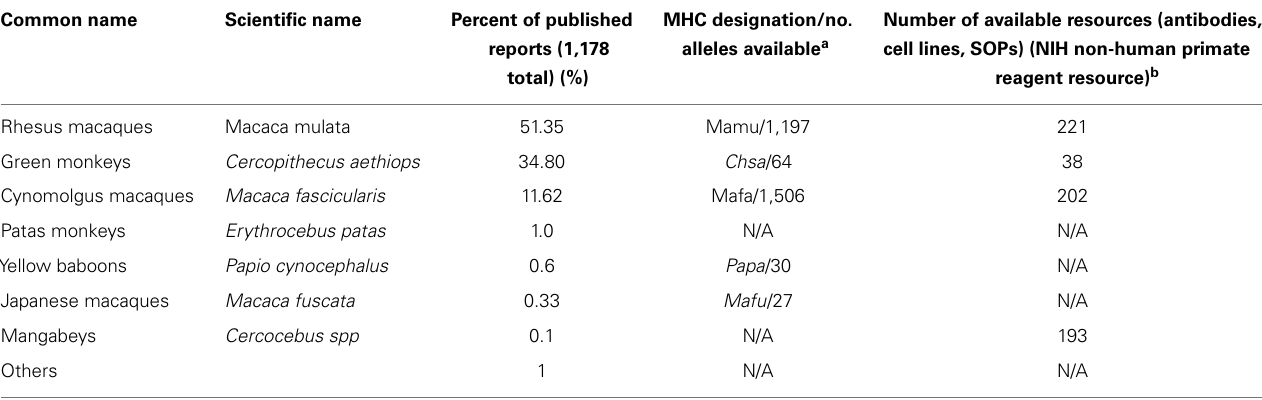
Table 2 | Species of NHP used in dengue pathogenesis and vaccine studies